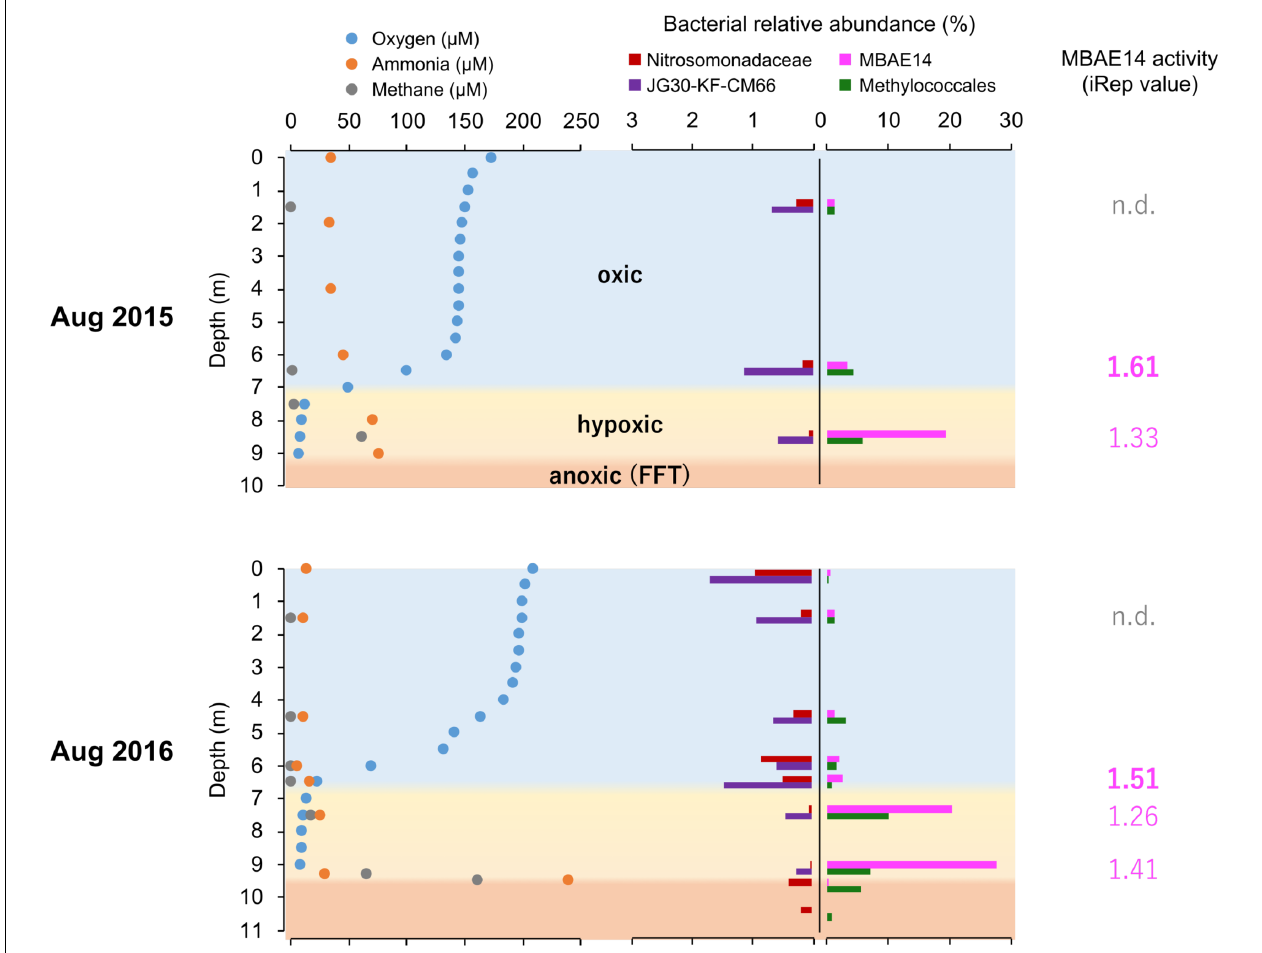
FIGURE 3 | Summarized dissolved oxygen, ammonia and methane concentrations ( µ M) profiles, relative abundances (%) of putative nitrifiers and methanotrophs, as well as activity values based on iRep for MBAE14 in the Base Mine Lake water column in 2015 (above) and 2016 (below). Profiles of dissolved oxygen (blue), ammonia (orange) and methane (gray) depict oxic (light blue), hypoxic ( < 0.5 mg/L = ∼ 16 µ M dissolved oxygen, yellow) and anoxic ( < 0.1 mg/L = ∼ 3 µ M dissolved oxygen, orange) zones. Relative abundances of typical AOB Nitrosomonadaceae (red), putative nitrite-oxidizing Chloroflexi JG30-KF-CM66 (purple), putative AOB MBAE14 (pink), and methanotroph Methylococcales (green) in the Base Mine Lake water cap as well as in the FFT zones (only 2016) are shown in different colors. n.d., not